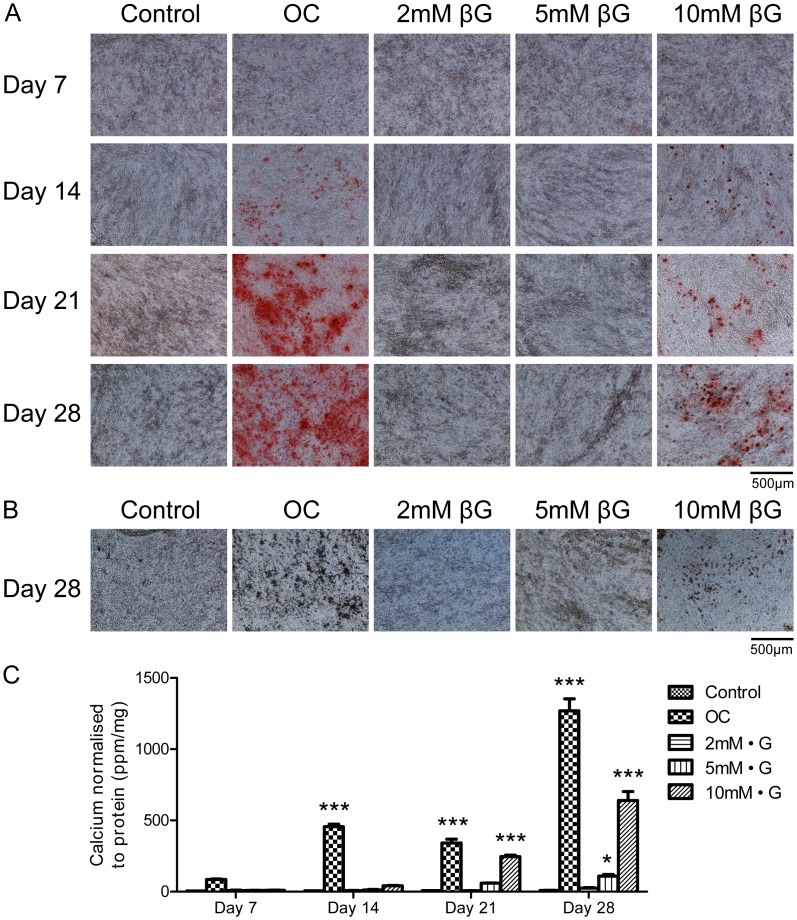
Investigating the effect of increasing concentrations of β-glycerophosphate on 4T1 cell mineralization.Representative images were captured at 100× magnification and the scale bars represent 500 µm. (A) Positive alizarin red S staining for calcium (red) was observed in the OC, 5 mM βG and 10 mM βG treated groups, beginning on days 14, 28 and 14 respectively. (B) Positive von Kossa staining for calcium phosphate (black/brown) was observed in the OC, 5 mM βG and 10 mM βG treated groups on day 28. (C) The calcium content of 4T1 cells as determined by the o-cresolphthalein calcium assay and normalized to protein. Increases in calcium were observed in the OC and 10 mM βG treated groups over time. Each point represents the mean amount of calcium measured in ppm normalized to protein measured in mg, +/− SEM, n = 3, two-way ANOVA. *P<0.05, ***P<0.001 vs. control at each time point. OC (osteogenic cocktail) = 50 µg/ml ascorbic acid and 10 mM β-glycerophosphate. βG = β-glycerophosphate.